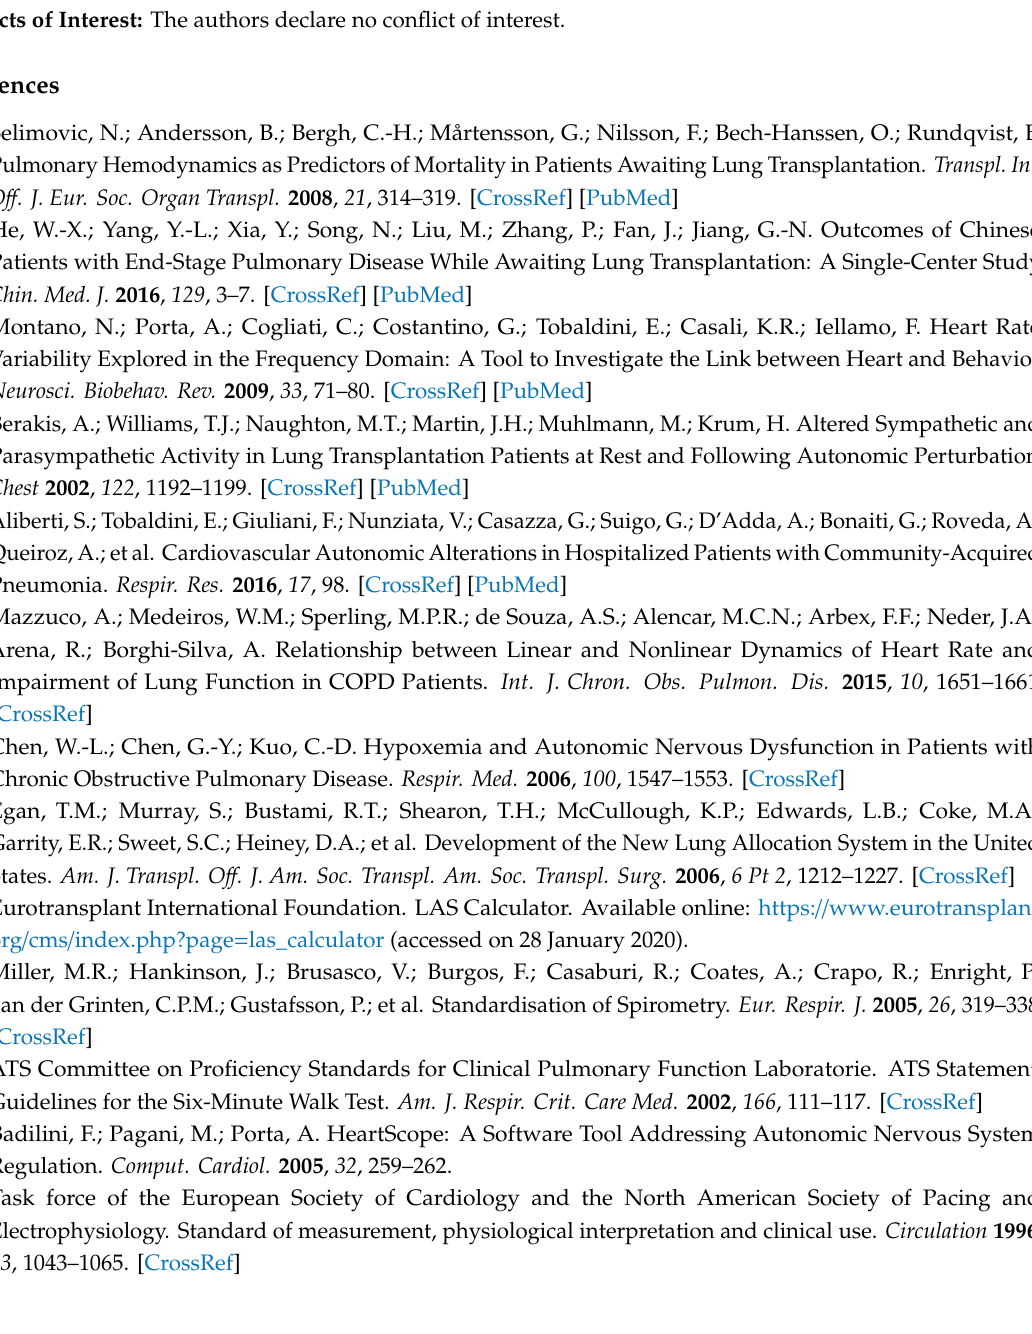
Table S1: Comparison of autonomic parameters evaluated by symbolic analysis between patients a ff ected by cystic fibrosis (CF) and patients a ff ected by other diseases (non-CF). Table S2: Comparison of autonomic parameters evaluated by symbolic analysis between patients a ff ected by CF and patients a ff ected by other diseases (non-CF); only patients with a LAS lower than the median LAS of the whole sample are considered. Table S3: Comparison of autonomic parameters evaluated by symbolic analysis between patients a ff ected by CF and patients a ff ected by other diseases (non-CF); only patients with a LAS higher than the median LAS of the whole sample are